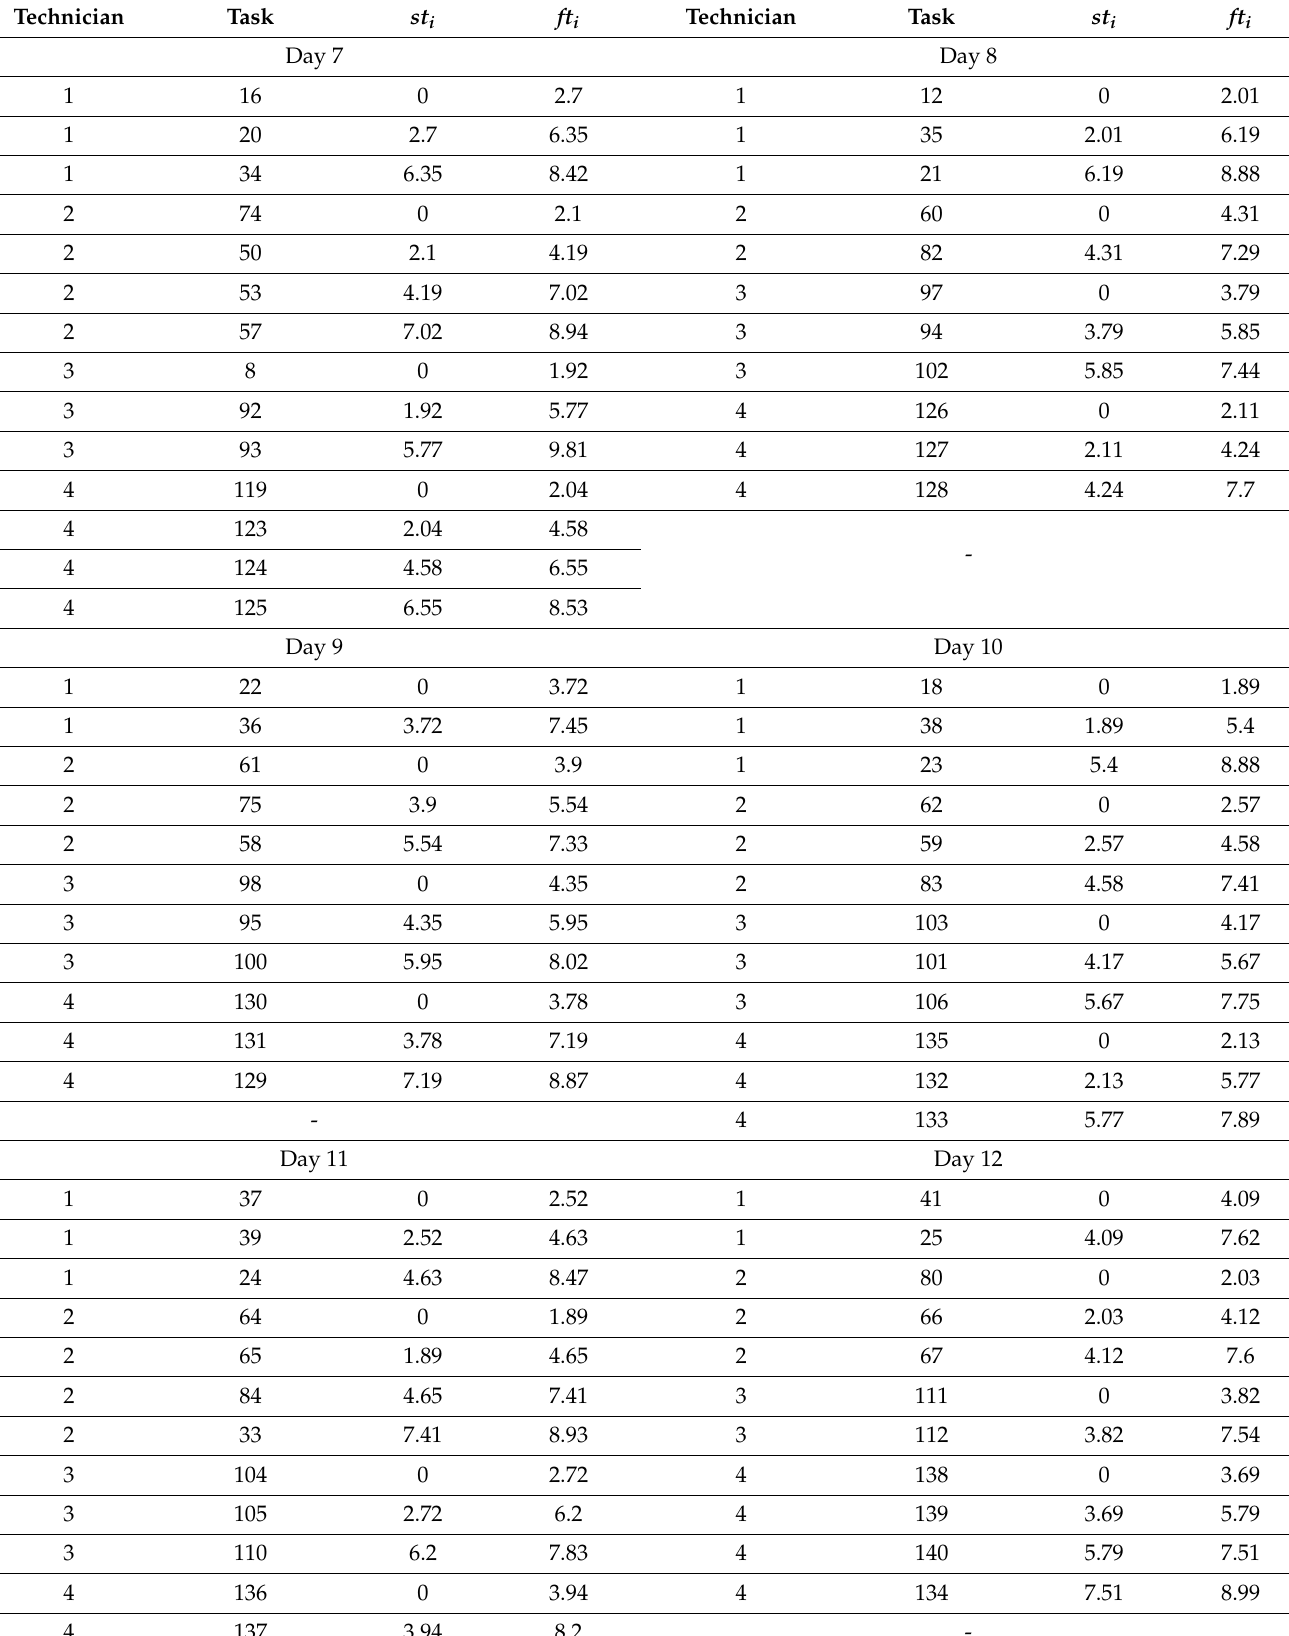
Table 12. The sequencing timeframe for tasks from day 7 to